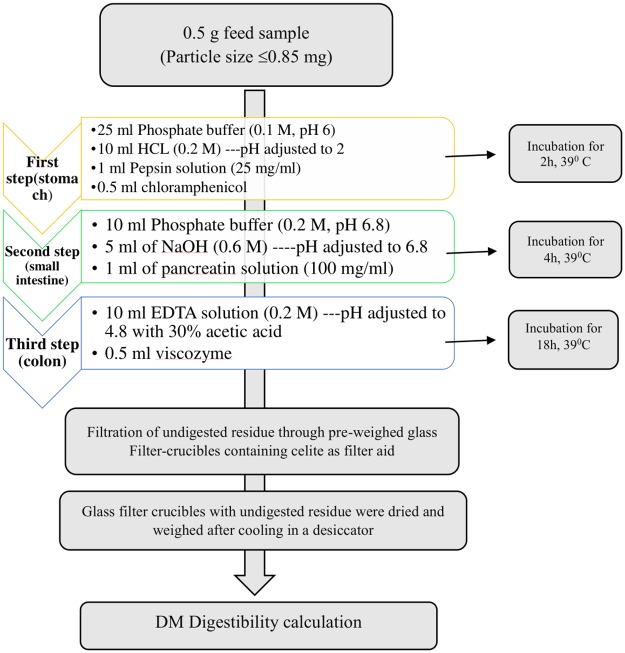
Schematic representation of IVTTD.